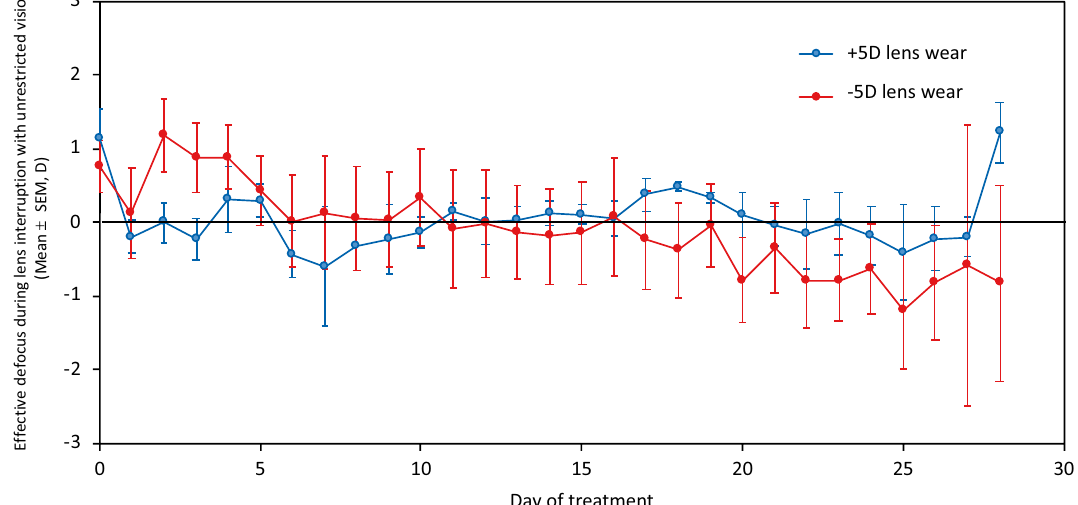
Figure 6. Daily average of the defocus experienced by marmosets during the normal light interruption while they were kept inside a cylinder on which natural scenes were projected. The defocus in the + 5D group is represented in blue, and the defocus in the − 5D group is shown in